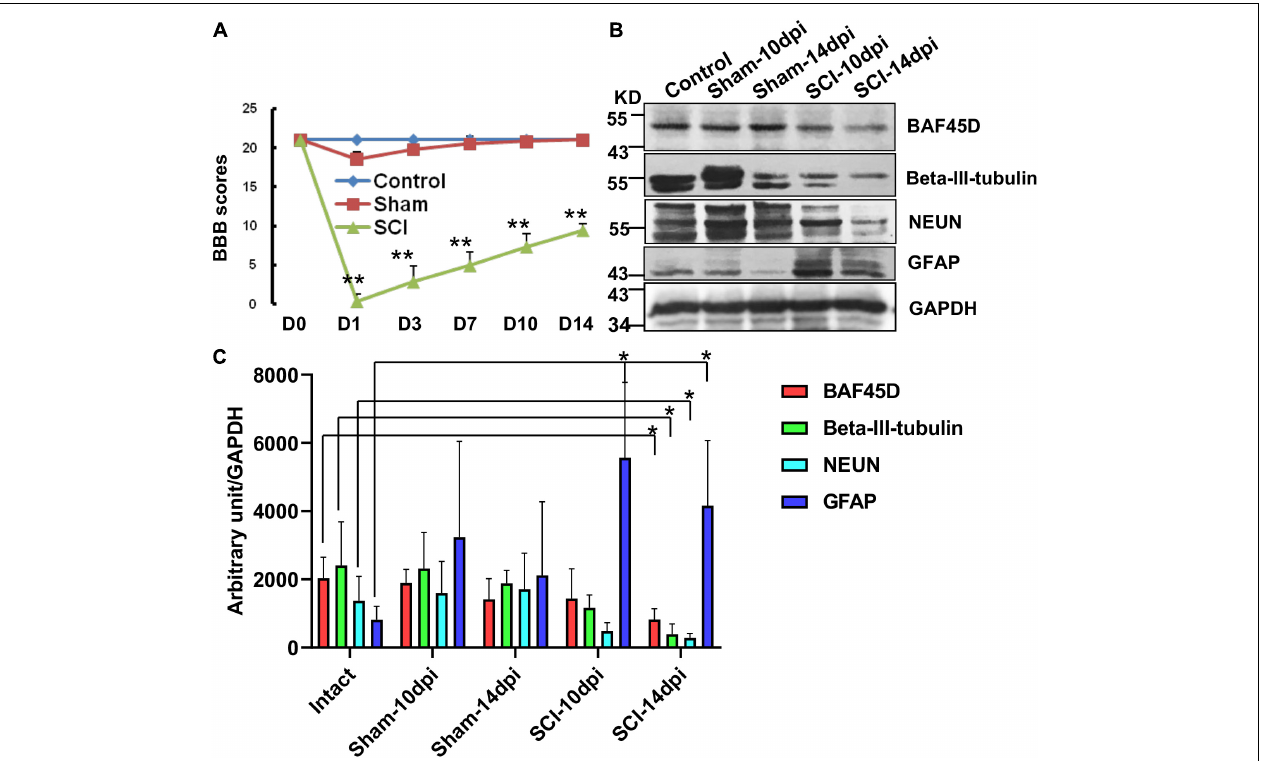
FIGURE 4 | Downregulation of BAF45D at lesion sites following SCI in adult rats. (A) Hindlimb movements were evaluated using the 21-point BBB rating scale. (B) The expression of neural proteins was examined by IB assays using the indicated antibodies in intact and injured spinal cord tissues. (C) IB assays were replicated four times, and protein levels were quantified by Image J software. Protein levels (expressed in arbitrary units) were normalized to the levels of GAPDH and were subjected to independent t -tests using SPSS 17.0 software. ∗ P < 0.05, as compared with the intact group.